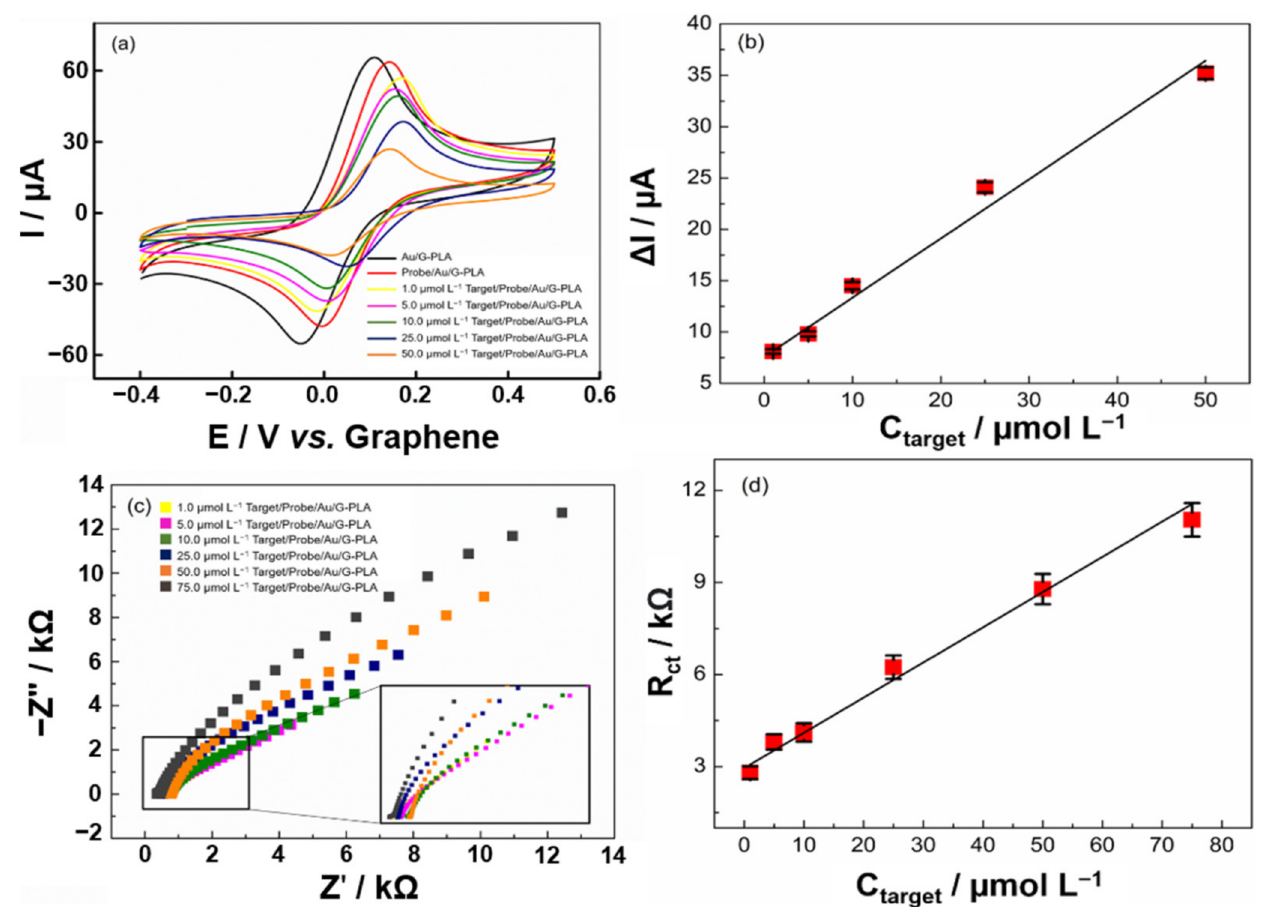
Figure 6. Biosensor calibration curve employing ( a ) CV and ( c ) EIS techniques, in the range of 1.0 to 50.0 µ mol L − 1 and 1.0 to 75.0 µ mol L − 1 target, respectively. ( b ) CV calibration curves were obtained between the difference of the biosensor analytical signal in the absence and presence of the target sequence employing 1.0 mmol L − 1 ferrocenemethanol in 0.1 mol L − 1 KCl. ( d ) EIS calibration curve was constructed from the obtained R ct